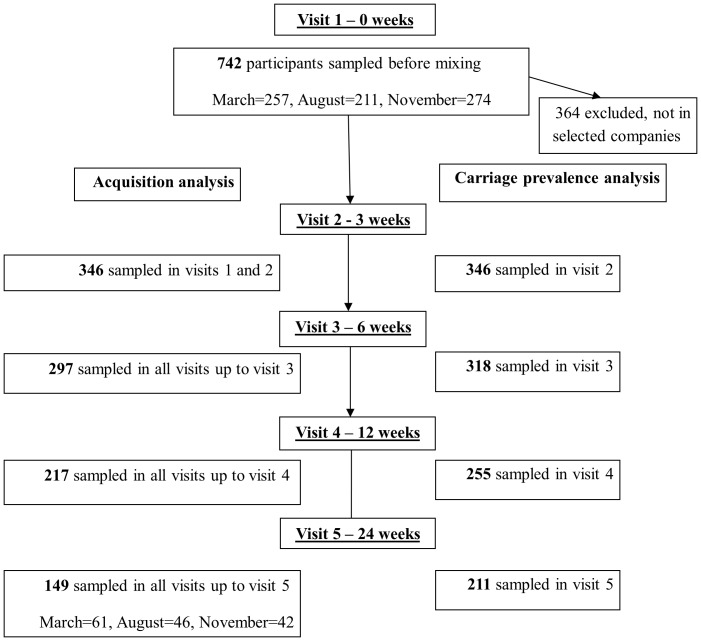
Flow chart of 742 participants in pneumococcal carriage study, for acquisition and for carriage prevalence analyses.